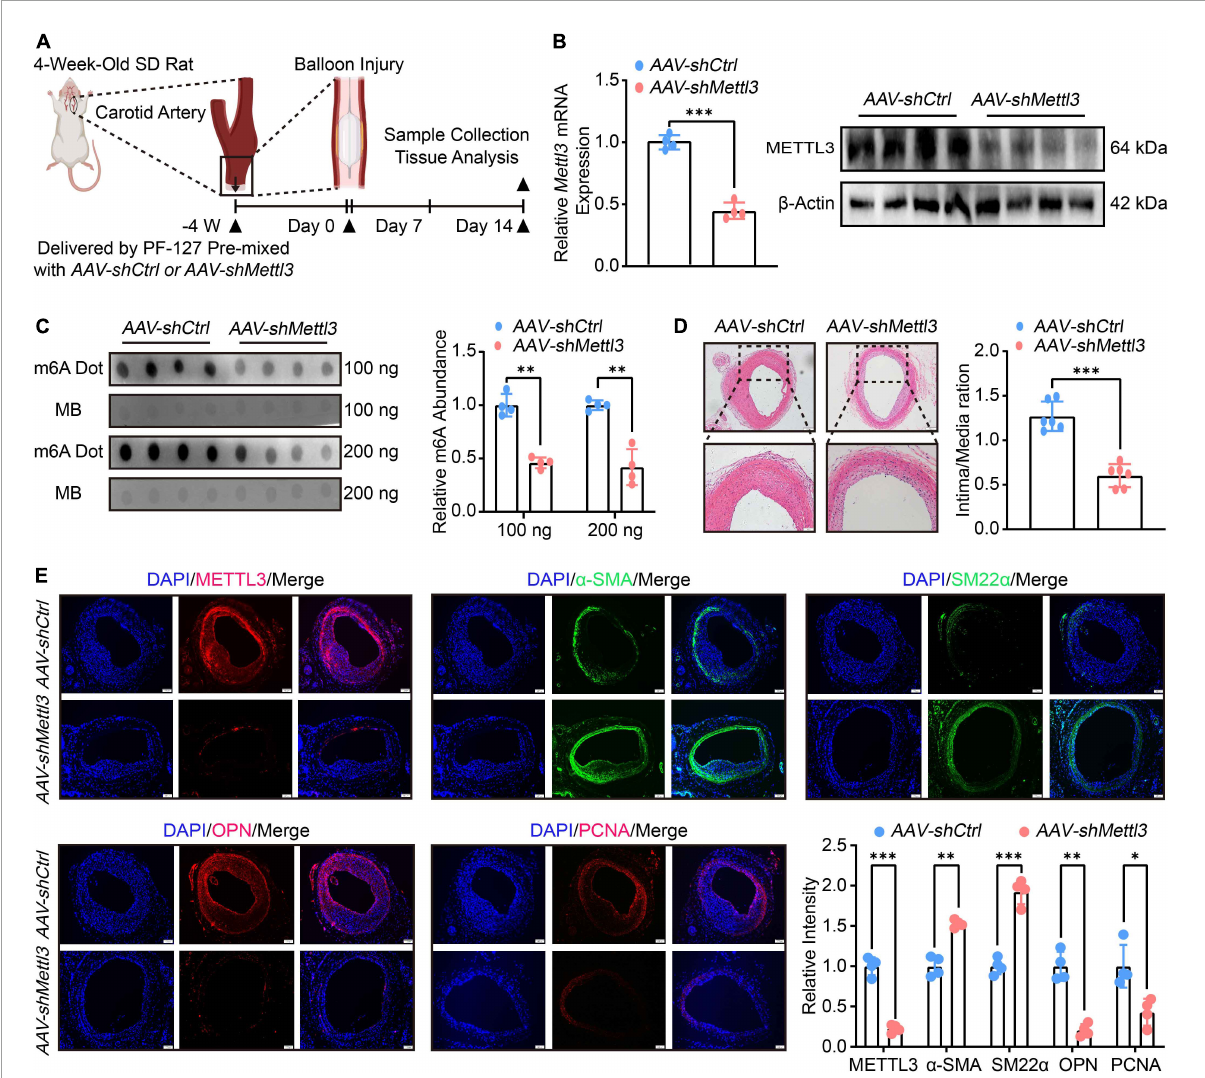
FIGURE2 Reduced N6-methylatidine (m6A) and neointimal hyperplasia are associated with methyltransferase like 3 (METTL3) downregulation. (A) Schematic illustration of the experimental procedure. The carotid arteries of 4-week-old SD rats were treated with PF-127 mixed with AAV-shCtrl or AAV-shMettl3 . Four weeks later, the rats were subject to balloon injured. 14 days after surgery, samples were harvested for further investigations. (B) Quantification analysis of Mettl3 expression measured by RT-qPCR and Western Blot images showing METTL3 level after delivery of AAV and subject to carotid artery balloon injury. (C) Dot Blot image (left panel) and relative m6A abundance quantification (right panel). (D) Representative HE staining images (left panel) and quantification (right panel) of intima area ( n = 6, scale bar = 100 µ m). (E) Representative immunofluorescence images showing METTL3, α -SMA, PCNA, OPN, and SM22 α levels (scale bar = 100 µ m). Three randomly selected fields for each sample were visualized. Data were from at least four independent biological replicates unless specified and presented as mean ± SD. ∗ p < 0.05, ∗∗ p < 0.01 and ∗∗∗ p <